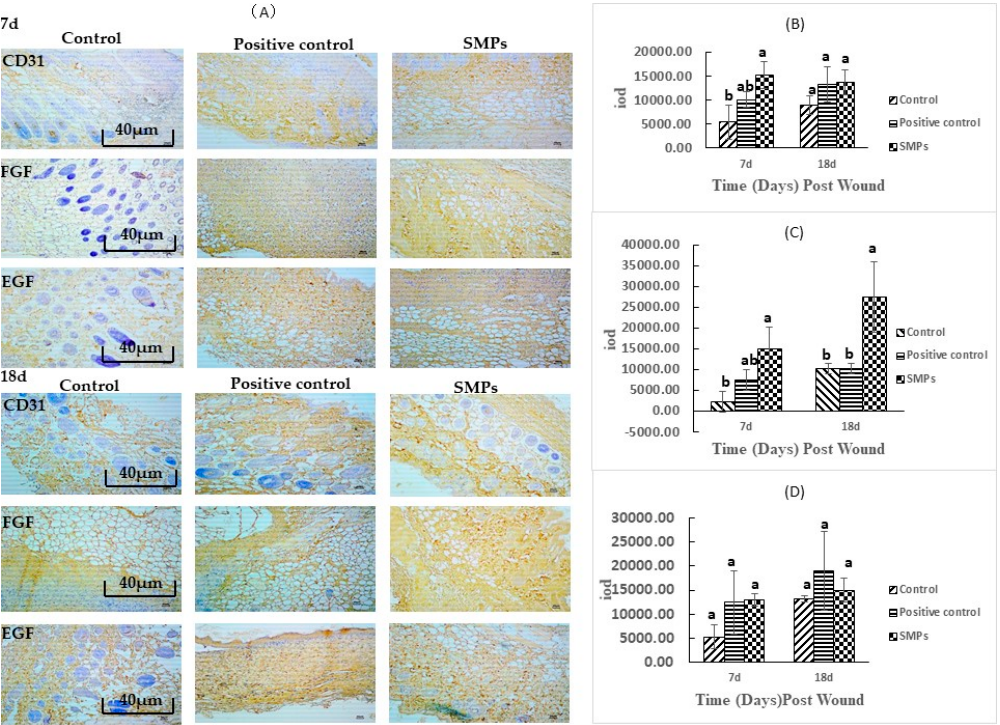
Figure 5. Immunohistochemical analysis chart. ( A ) Representative images of CD31, FGF and EGF immunostaining on days 7 and 18 (scale bar: 40 μ m). ( B ) Expression of CD31 at 7d and 18d after trauma. ( C ) Expression of FGF at 7d and 18d after trauma. ( D ) Expression of EGF at 7d and 18d after trauma. Different and same letters within the same row indicate significant ( p < 0.05) and insignificant different ( p > 0.05), respectively.